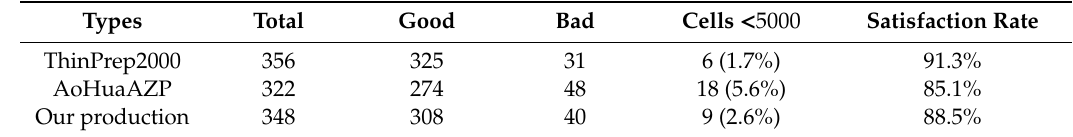
Table 1. Test results comparison of three